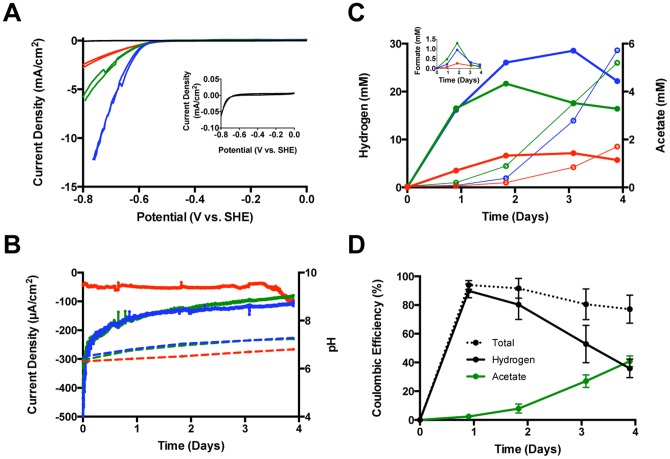
Yield and rate test.3 graphite rod biocathodes in phosphate buffered media with NaCl. A) Cyclic voltammetry at 1 mV/sec under constant CO2 sparging of Reactor 7 (red), Reactor 8 (green), Reactor 9 (blue) abiotic (black). Inset: magnification of the abiotic control. Yield tests data at −600 mV vs. SHE for B–D collected with sealed reactors (no sparging, 100% CO2 in headspace): B) current density (solid) and pH (dashed), C) hydrogen (thick solid), acetate (thin open), and formate (solid inset), D) Coulombic efficiencies for acetate (green), hydrogen (black) and total (black dotted) with standard deviation bars.